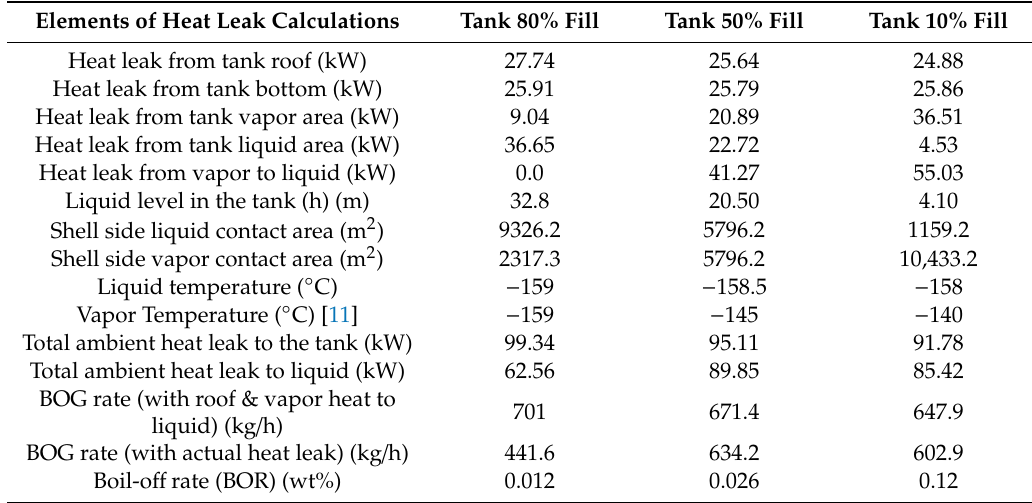
Table 7. The steady rate of heat leakage in the LNG tank for di ff erent liquid